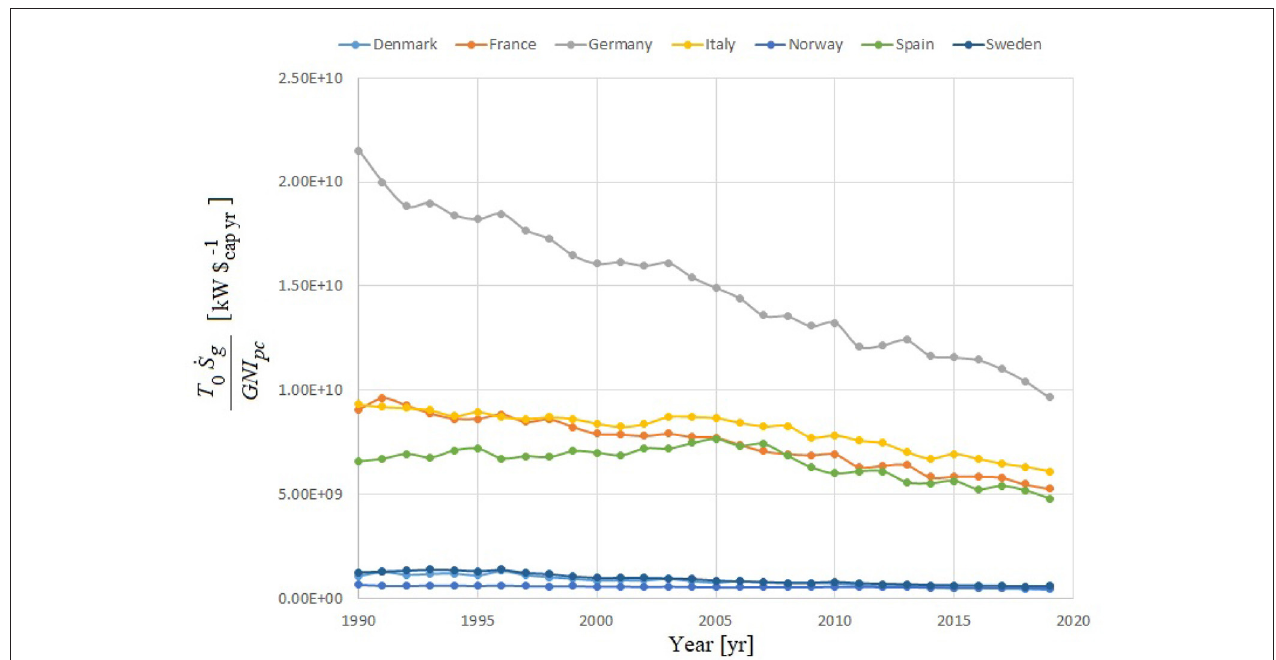
FIGURE 3 | In this figure, the trend of the proposed indicator is shown, as presented in Equation (10), considering the same useful effect ˙ W . The mean temperature, for the reference period for each country, has been calculated by using the World Bank data [ 54], and the related specific entropy for the carbon dioxide has been calculated by means of its thermodynamic properties tables.